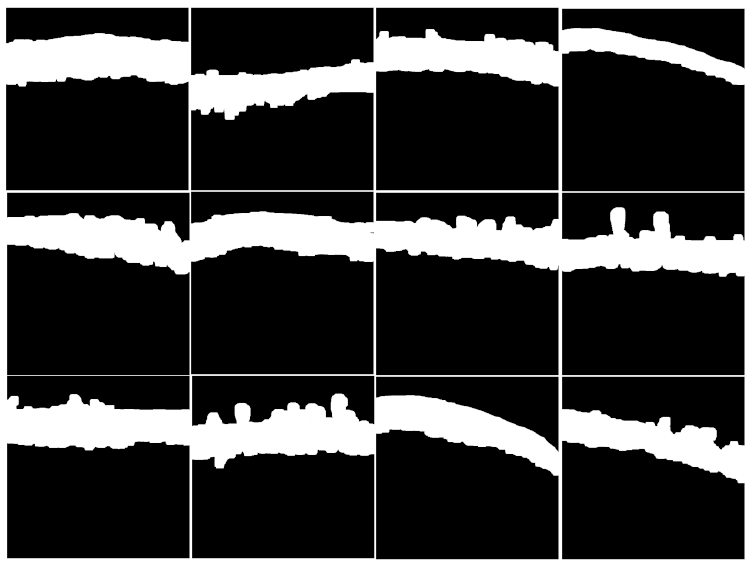
Figure 5. Exemplar binary masks generated during OCT image preprocessing. The white segments represent the regions of interest in the input